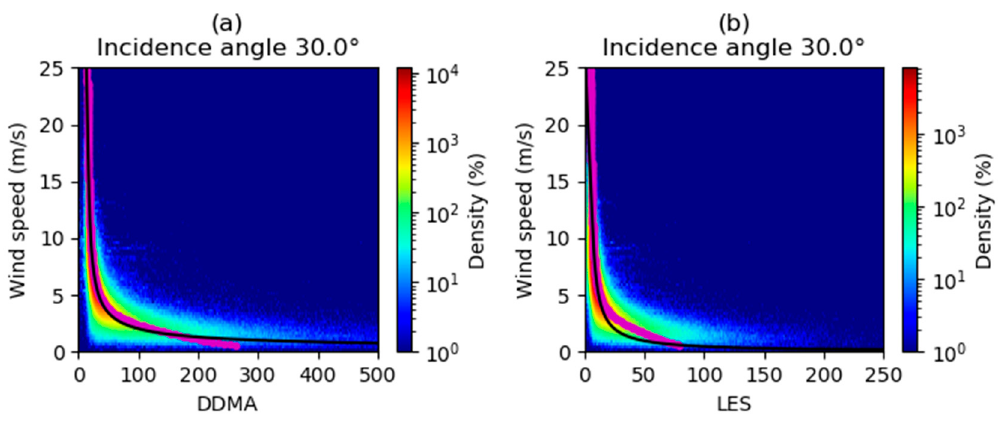
Figure 9. Delay-Doppler Map Average ( a ) and Leading Edge Slope ( b ) geophysical model function at an incident angle of 30° with the CCMP wind.